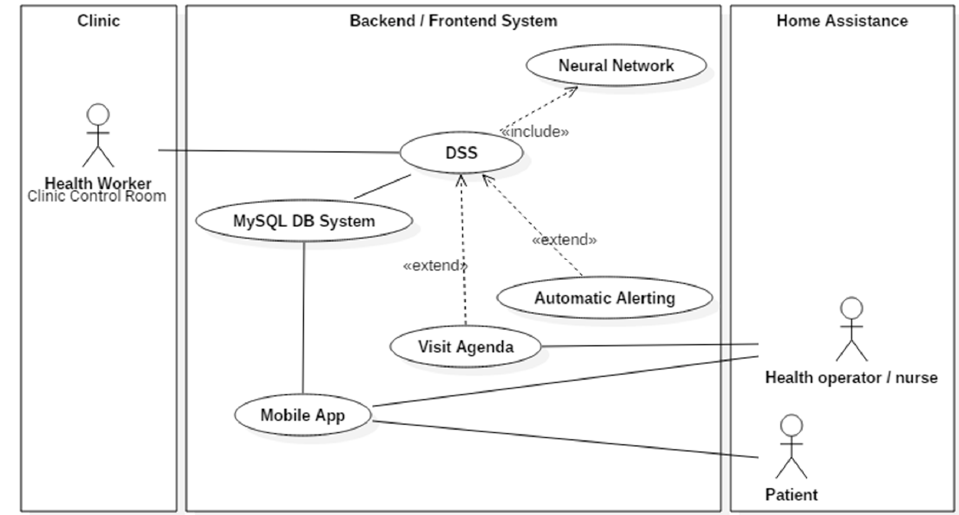
Figure 4. UML (unified modeling language) functional layout representing all the actors involved in the prototype architecture system.